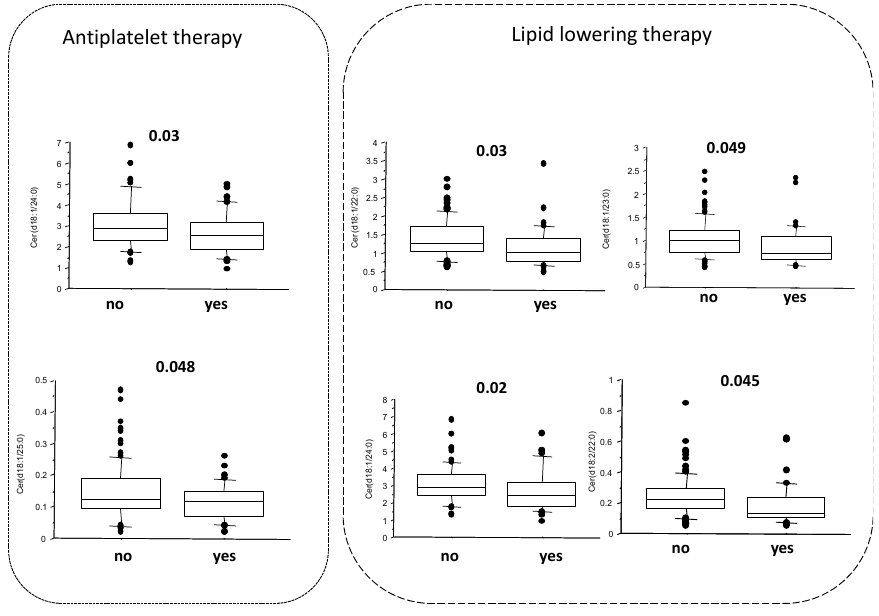
Figure 2. Reduction in specific ceramide species according to antiplatelet and lipid lowering ther- apy .